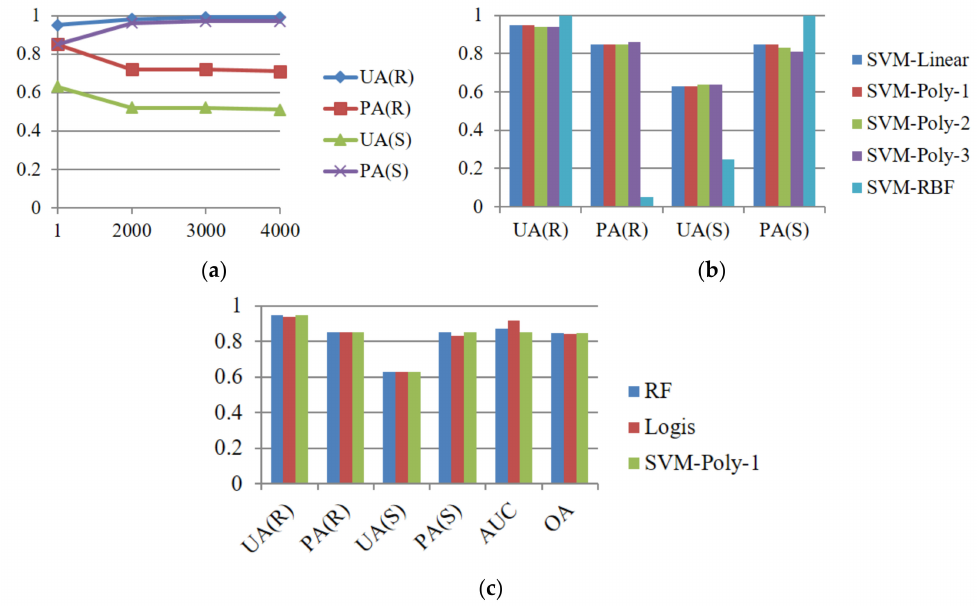
Figure 11. Performance ( Y -axis) of the No. 4 model, where OA, AUC, PA, UA, S, and R represent overall accuracy, area under the ROC curve, producer’s accuracy, user’s accuracy, landslide source, and runout, respectively. ( a ) Using the RF algorithm with the costs; ( b ) using SVM with linear, the first- to third-order polynomial, and radial basis (RBF) functions; ( c ) comparing the optimal results of ( a ) and ( b ) with logistic (Logis)